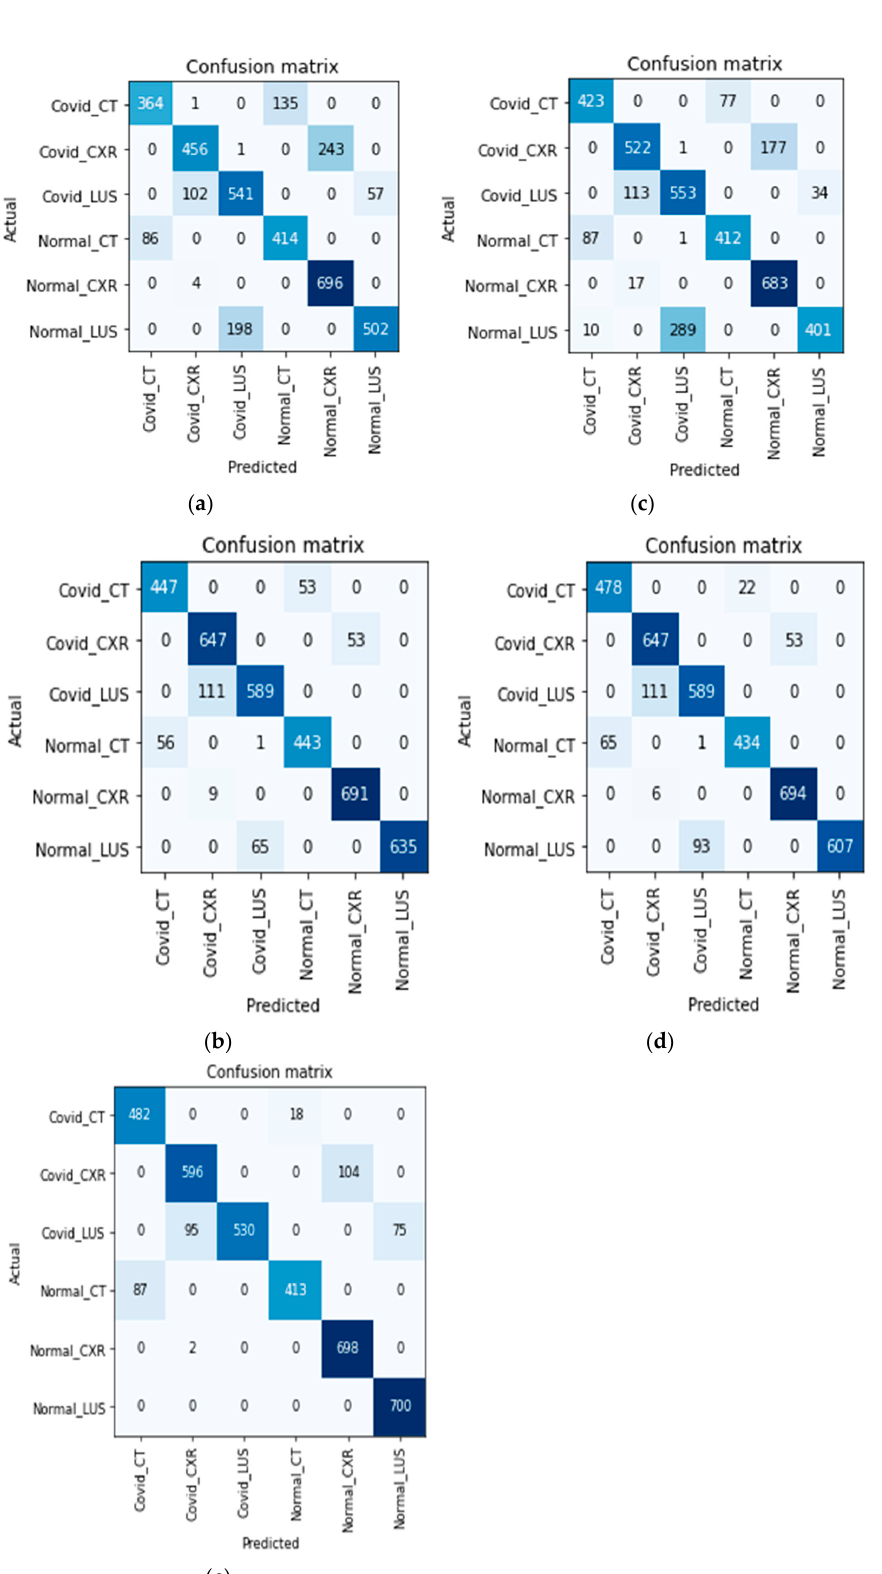
Figure 6. The confusion matrix of the models on validation dataset. ( a ) Confusion matrix of ResNet Model; ( b ) Confusion matrix of XResNet only; ( c ) Confusion matrix of XResNet with Self-Attention; ( d ) Confusion matrix of XResNet + Self-Attention + Lookahead Optimizer; ( e ) Confusion matrix of ResNet with DFT.